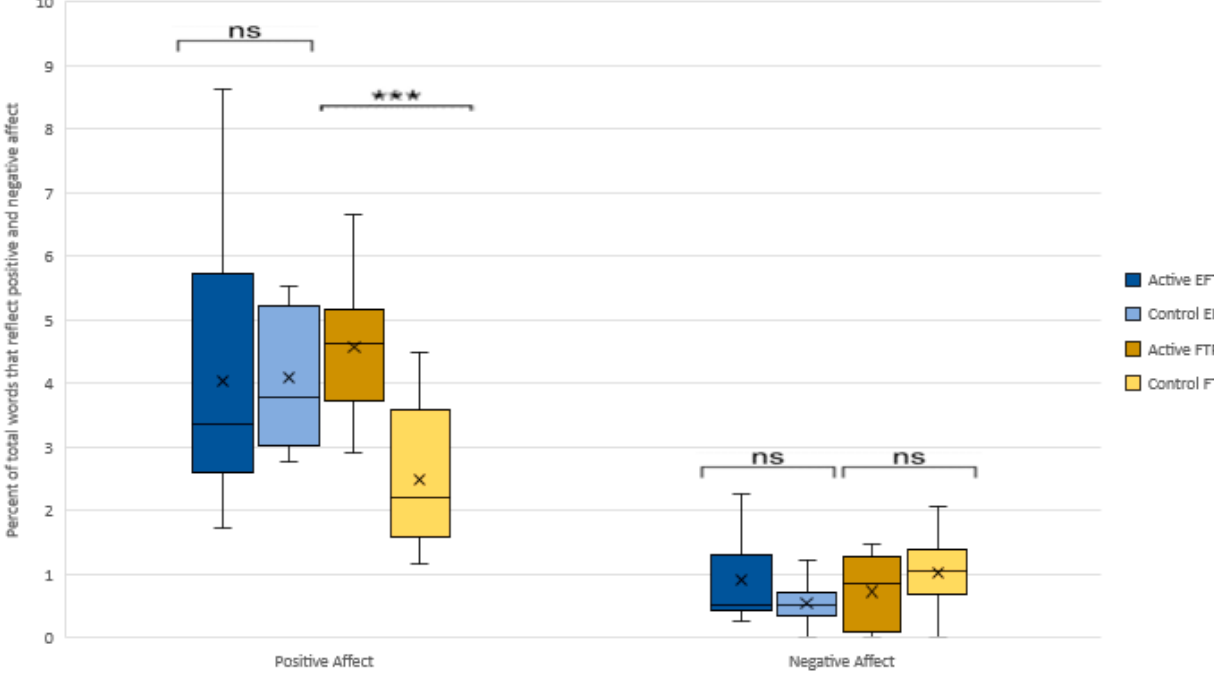
Figure 4. Percentage of total words that reflect positive and negative affect for Episodic Future Thinking and Future Thinking Priming active vs. control conditions. *** = p < 0.001, ns = not significant.